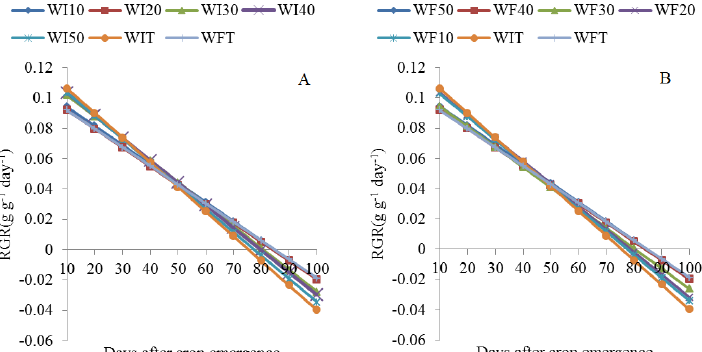
Fig. 4. Dry bean relative growth rate (RGR) trend over time at different treatments of weed interference (A) and weed free (B) peri- ods. WI10, WI20, WI30, WI40 and WI50: weed infested periods until 10, 20, 30, 40 and 50 days after crop emergence, respective- ly; WF10, WF20, WF30, WF40 and WF50: weed free periods until 10, 20, 30, 40 and 50 days after crop emergence, respectively;